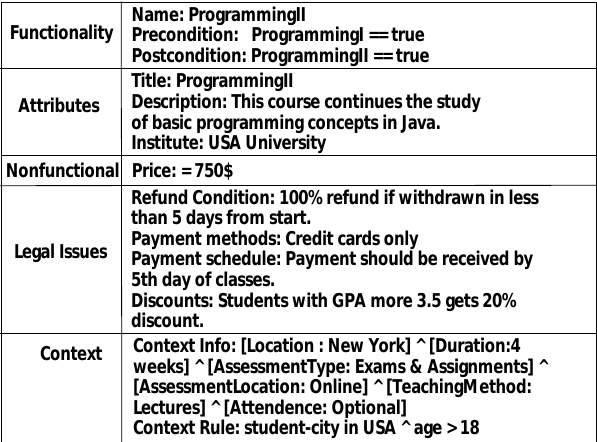
Figure 4. ProgrammingII